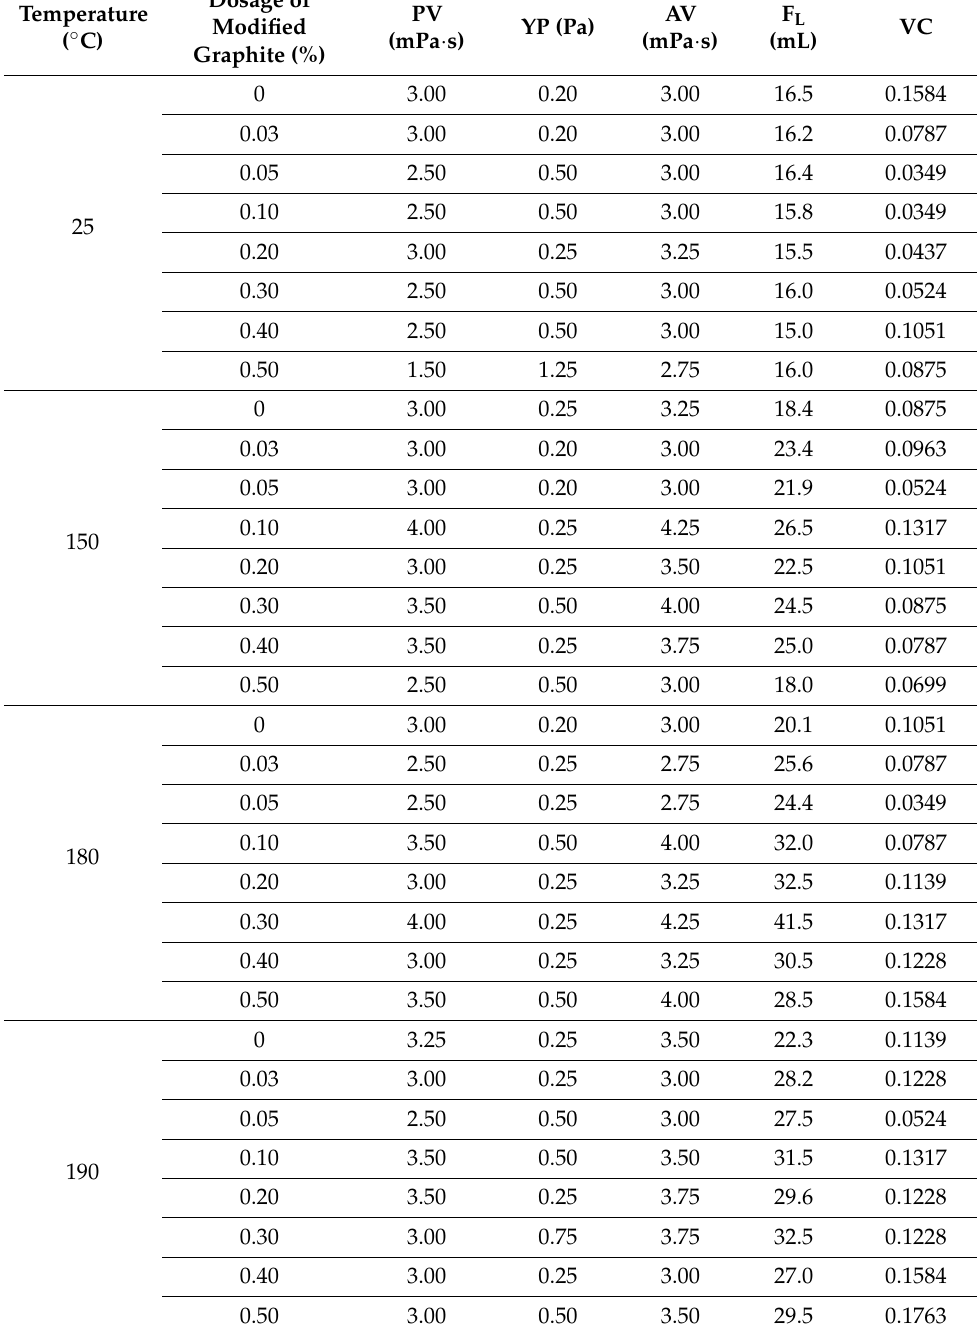
Performance of drilling fluid with the addition of different dosages of CTAC- modified